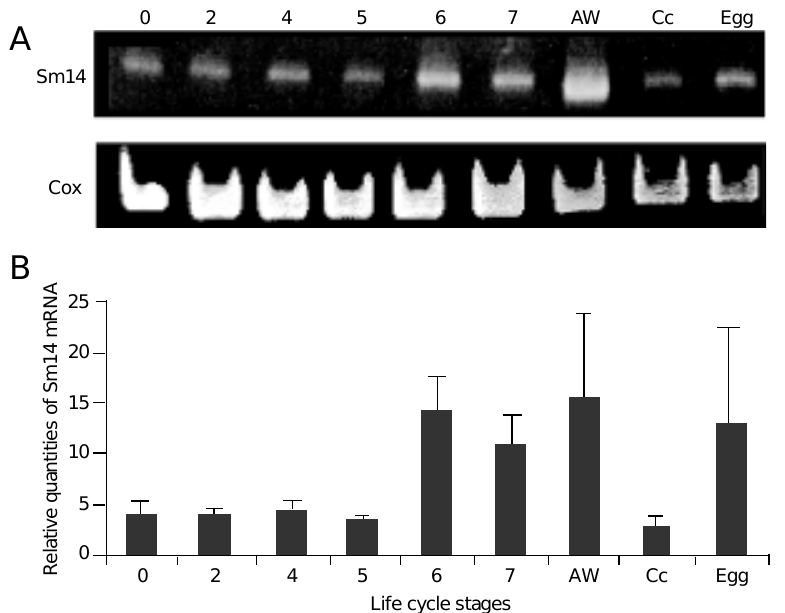
Figure 1. A , Amplification of cDNA from a Schistosoma mansoni newly transformed schistosomulum (0), and from 2, 4, 5, 6 or 7-day-cultured schistosomula; adult worm (AW); cercariae (Cc) or egg using specific primers for Sm14 or Cox. B , The data represent relative quantities of specific Sm14 mRNA in relation to the Cox transcripts (intensities of Sm14 in pixels x 100/intensities of Cox